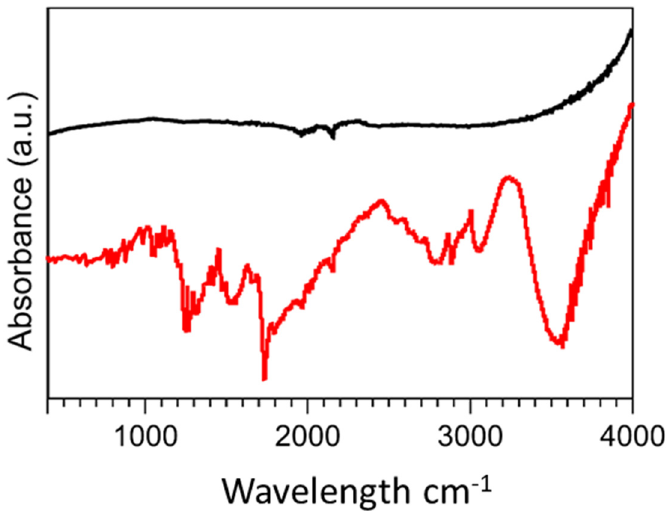
Figure 3. FTIR spectra of (Black) unmodified MWCNTs and (Red) diamine oxidase conjugated MWCNTs.